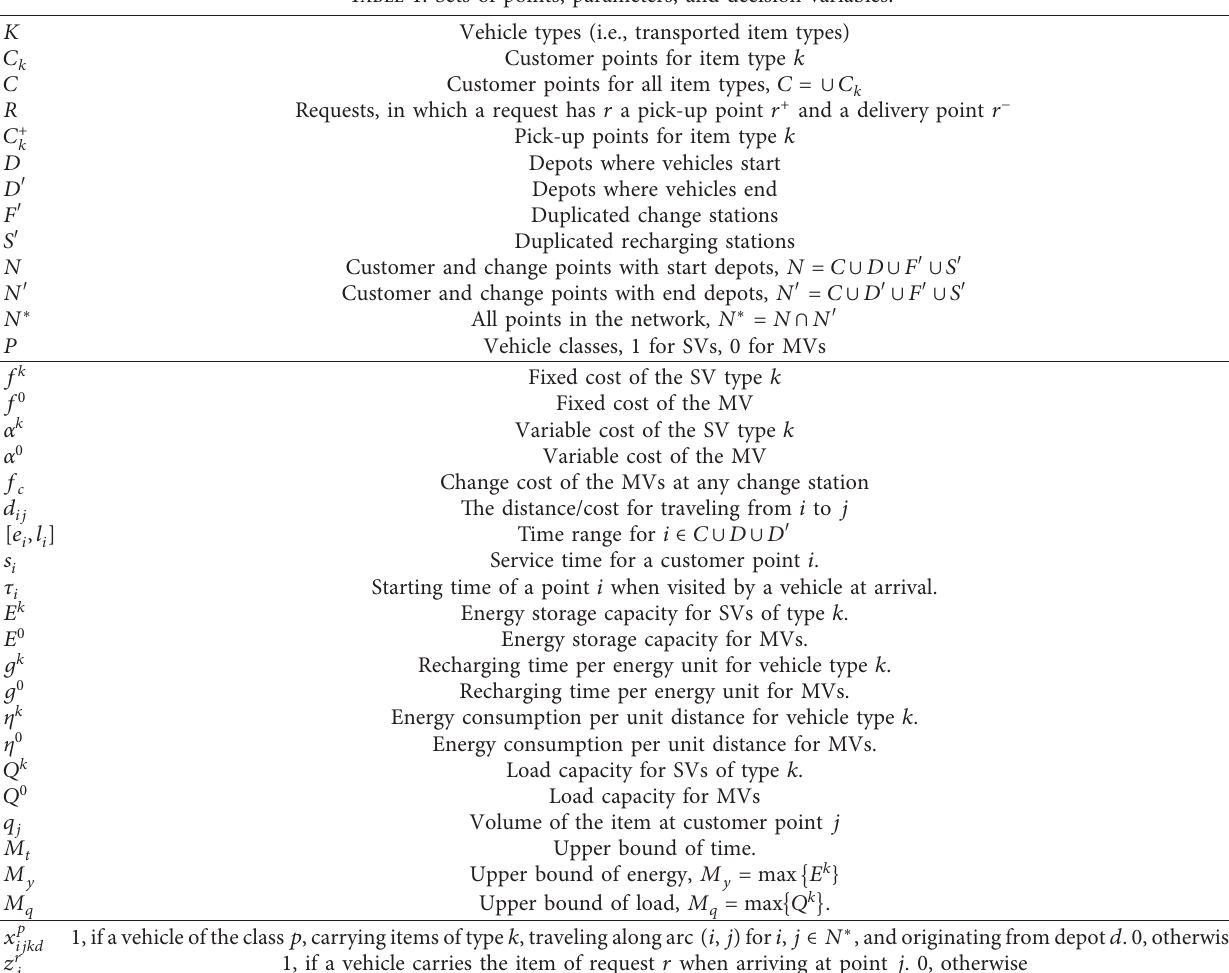
Table 1: Sets of points, parameters, and decision